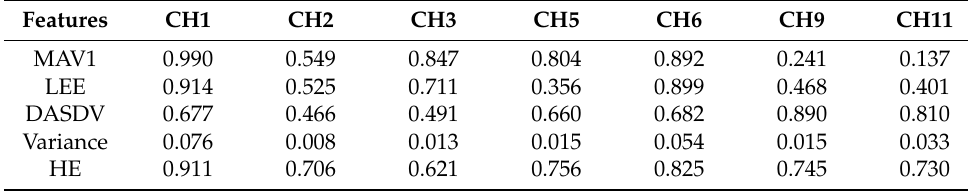
Table 2. Laplacian score of the features for the seven best channels.